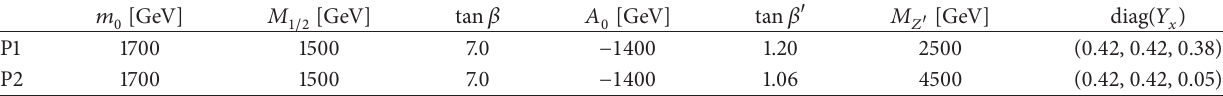
Table 7: Input parameters for the example points EP1 and EP2. In addition, we use sign (𝜇) = sign (𝜇 󸀠 ) = 1 and 𝑌 ] = 0